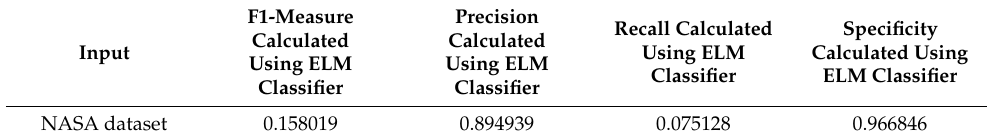
Table 3. F1-measure, Precision, Recall, and Specificity Calculation Table (Using ELM).